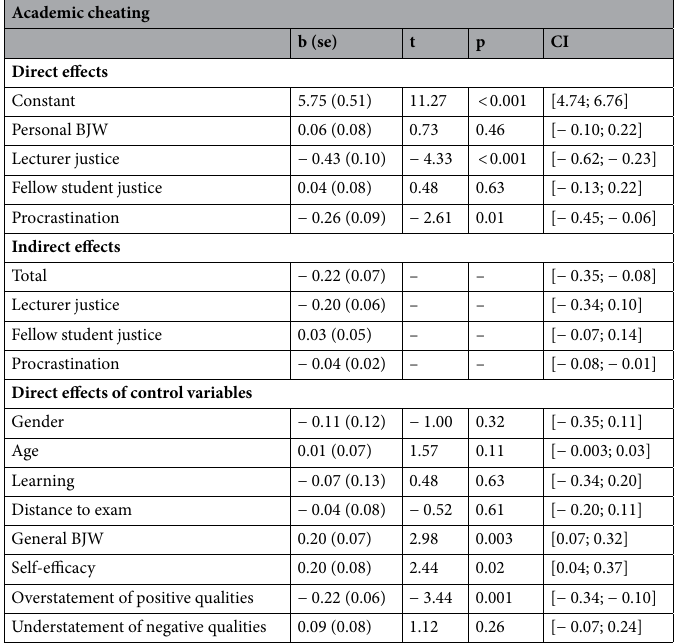
Table 3. Results of bootstrap mediation analyses for life satisfaction including control variables (N = 291 university students). BJW = Belief in a just world; For gender, 1 = female and 2 = male. Psychological variables ranged from 1 to 6 with lower values indicating stronger endorsement of the constructs, procrastination ranged from 1 to 5 with higher values indicating stronger endorsement of the constructs. Values